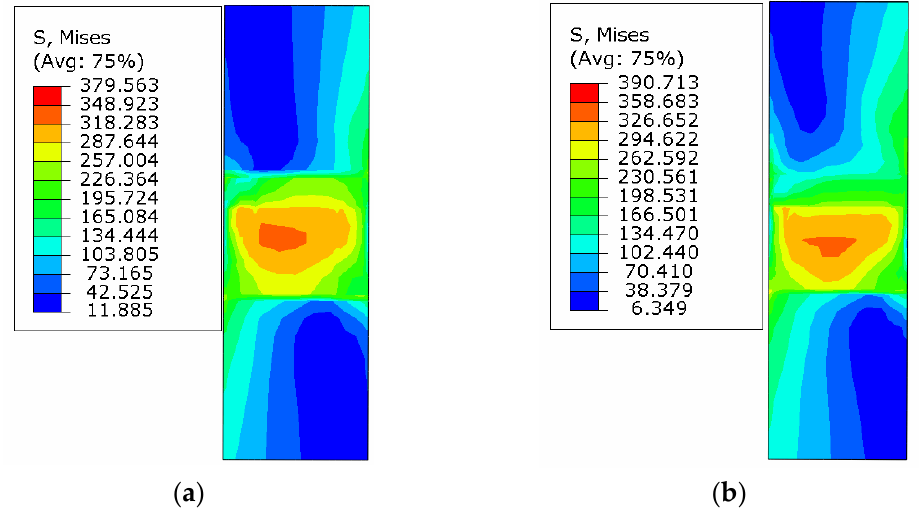
Figure 13. Von Mises stress contours in the webs of steel tube in connection zone at the yield state: ( a ) RS connection; ( b ) RT connection.